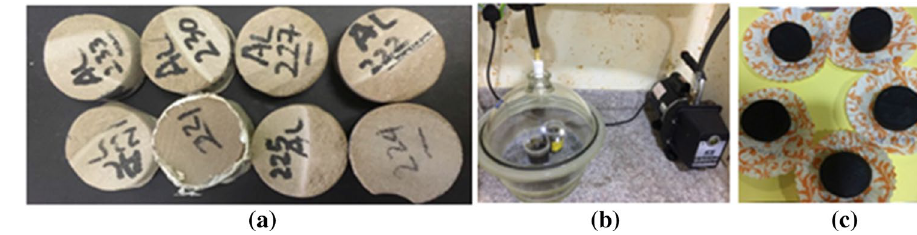
Fig. 1 a Core plugs after dry- ing. b Saturating core plugs with crude oil. c Cores after